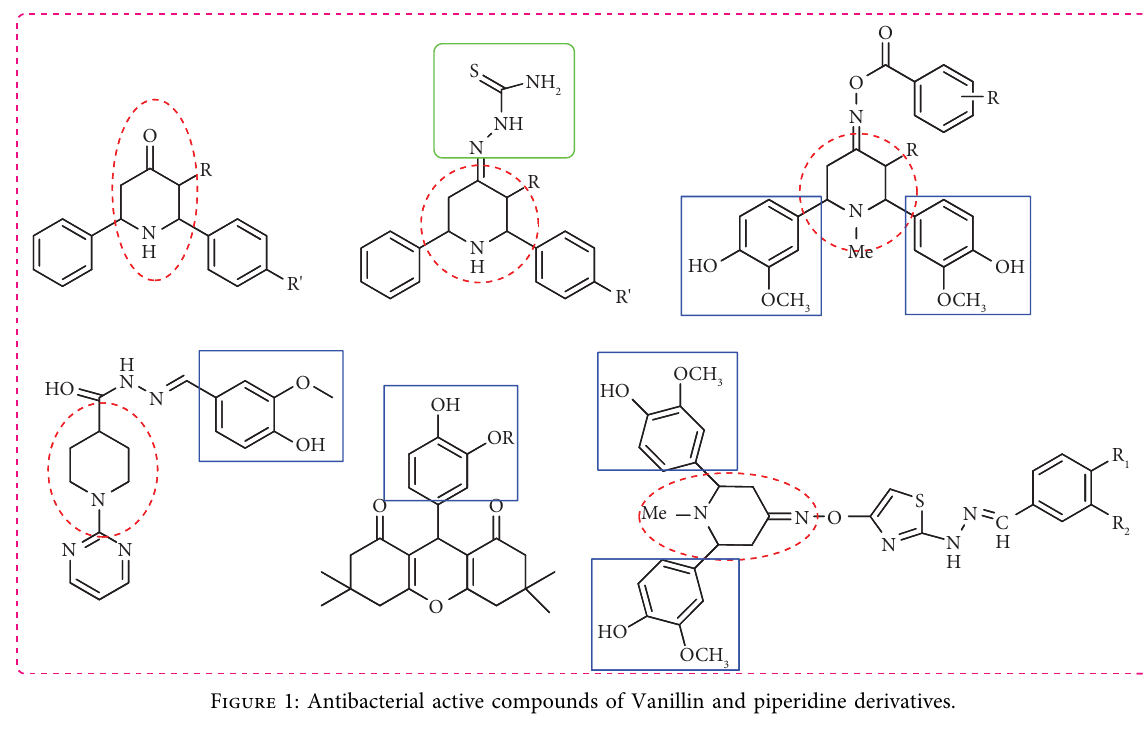
Figure 1: Antibacterial active compounds of Vanillin and piperidine derivatives.